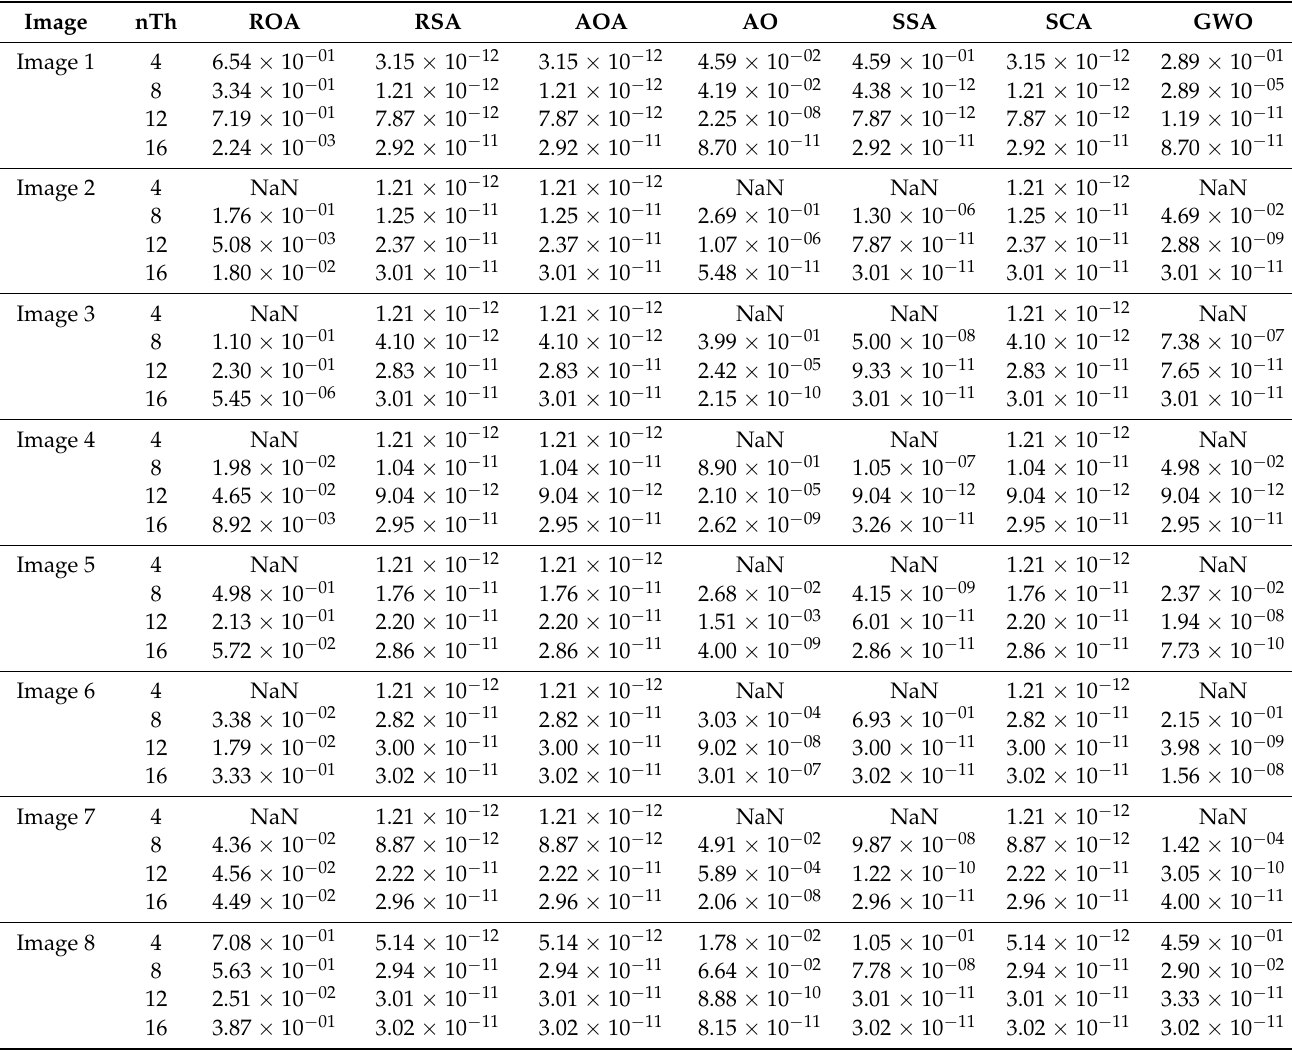
Table A7. The p -values obtained by algorithms over all images.